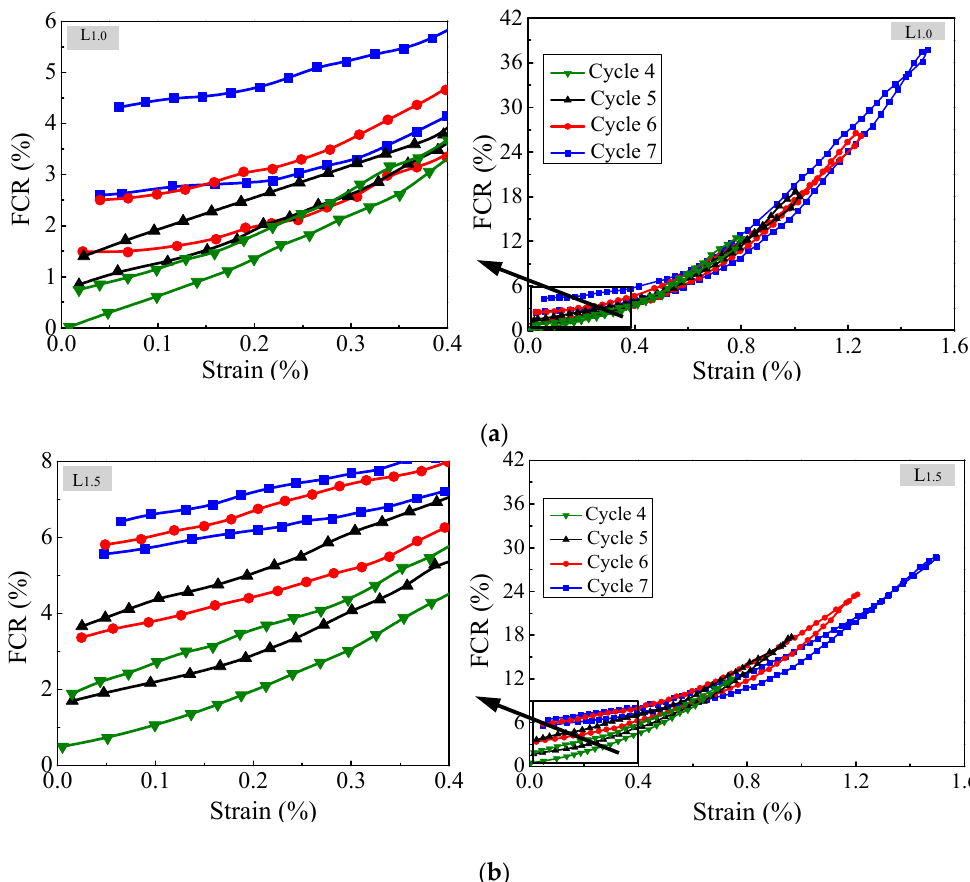
Figure 12. Typical in situ monitoring of ( a ) L 1.0 and ( b ) L 1.5 under incremental amplitude cyclic tensile loading.